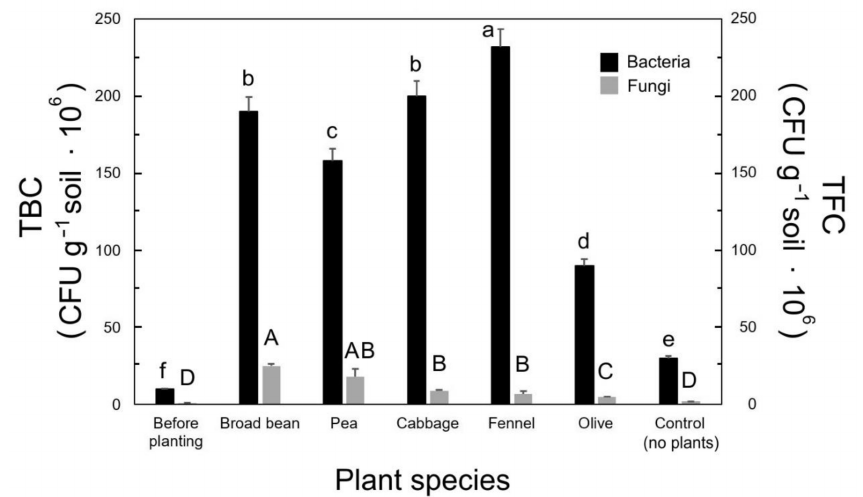
Figure 1. Total bacterial count (TBC) and total fungal count (TFC) from soils with di ff erent plant species. Each value represents the mean ( ± SD) of five replicates (composite soil samples; n = 5) for each species. The values followed by di ff erent letters (a–f; lowercase for TBC and uppercase for TFC) are statistically di ff erent ( p ≤